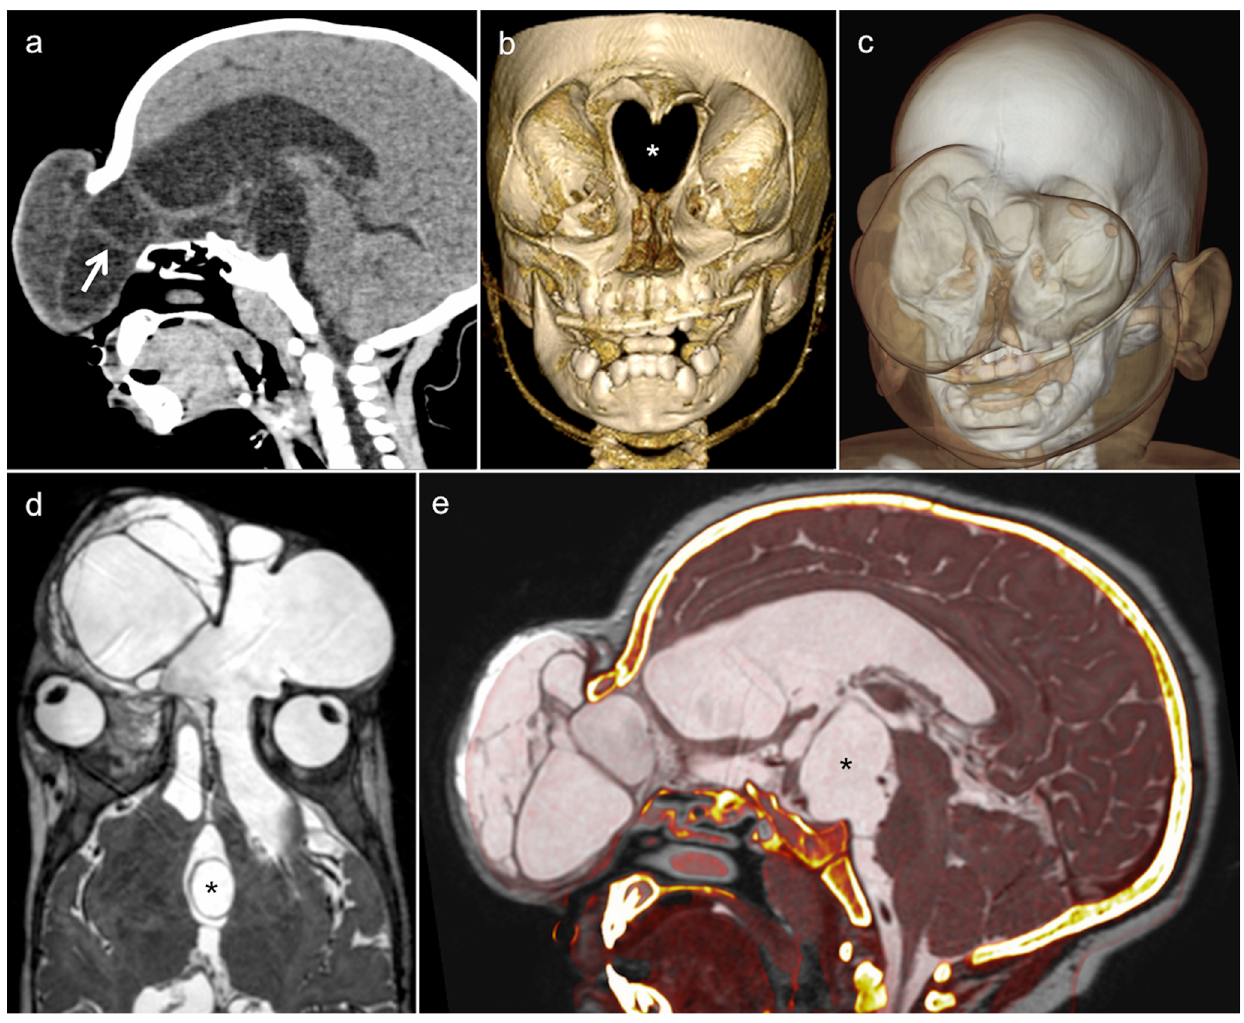
Fig. 13 Meningoencephalocele in a 13-month-old boy of African origin with a large midline facial mass. a Sagittal CT (brain window) shows herniation of cranial content through a bony defect located in the anterior skull base. The herniation contains a cyst-like mass with multiple septations and lined by glial tissue and/or meninges ( arrow ). b The exact size and configuration of the bony defect, as well as the extent of orbital bonymalformation,is better appreciated on thethree-dimensional CTVR